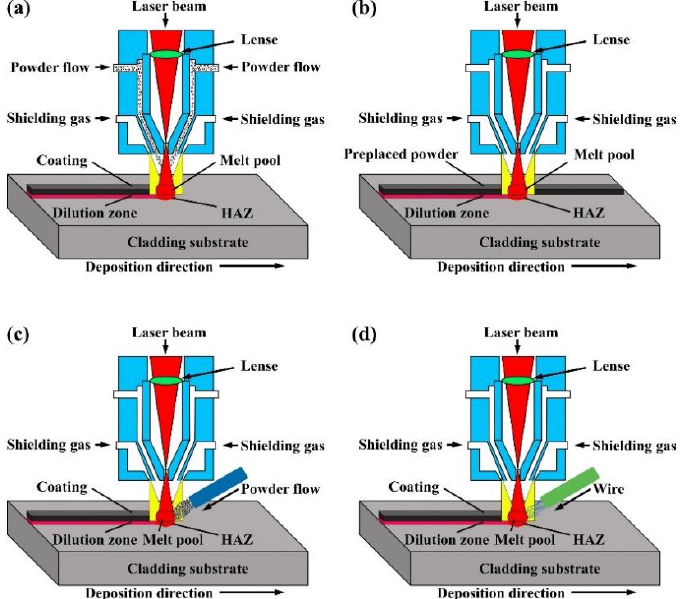
Figure 2. LC process: ( a ) coaxial powder feeding, ( b ) preplaced powder, ( c ) off-axis powder feeding, ( d ) wire feeding. Reproduced with permission from [45]. Copyright Elsevier, 2021.